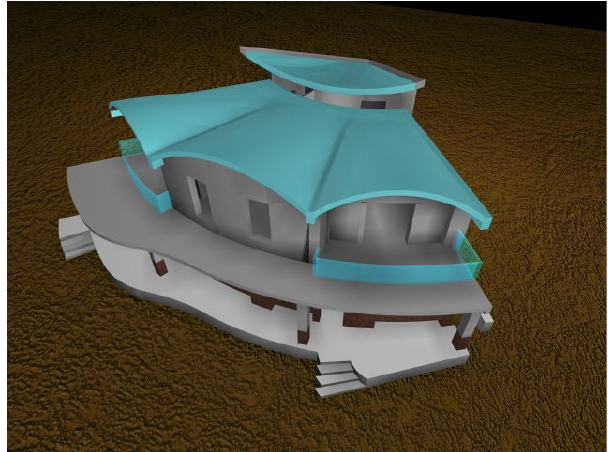
Figure 25. Three rotated conoidal roofs designed for a musicians’ family. Sanlucar (Seville).